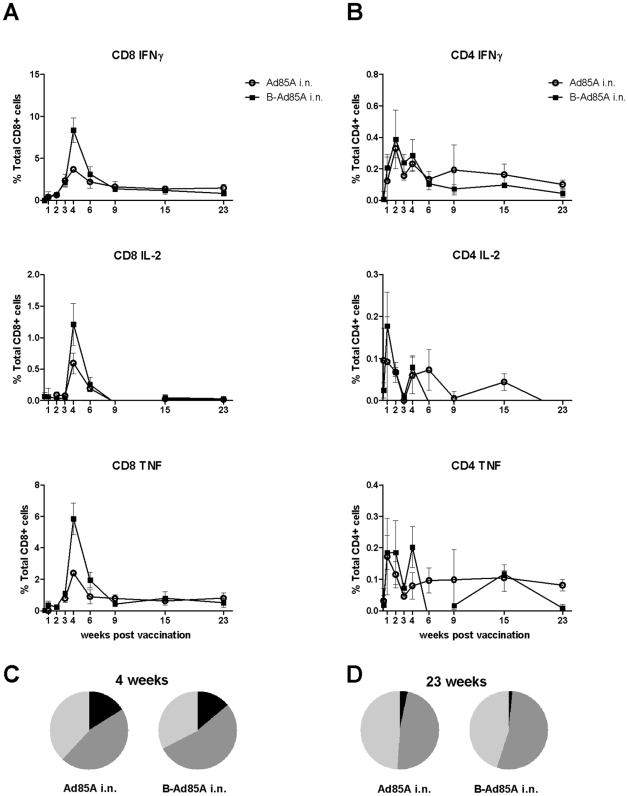
Cytokine responses of lung T cells to antigen 85A.Mice were immunized with Ad85A i.n. (Ad85A i.n.) or primed with BCG and boosted 8 weeks later with Ad85A intranasally (B-Ad85A i.n.). Lung cells were isolated at the indicated times after the last immunization and stimulated with pooled 85A peptides for 6 hours. The frequencies of IFNγ, IL-2 and TNFα producing cells were determined by flow cytometry on CD8 (A) and CD4 (B) gated cells. Pie charts indicate the proportions of single (light grey), dual (dark grey) and triple (black) CD8 producers of IFNγ, TNFα and IL-2 in the lungs of mice 4 (C) and 23 (D) weeks after immunization. Results are expressed as the mean +/− SEM of three/four mice per group, representative of two independent experiments.